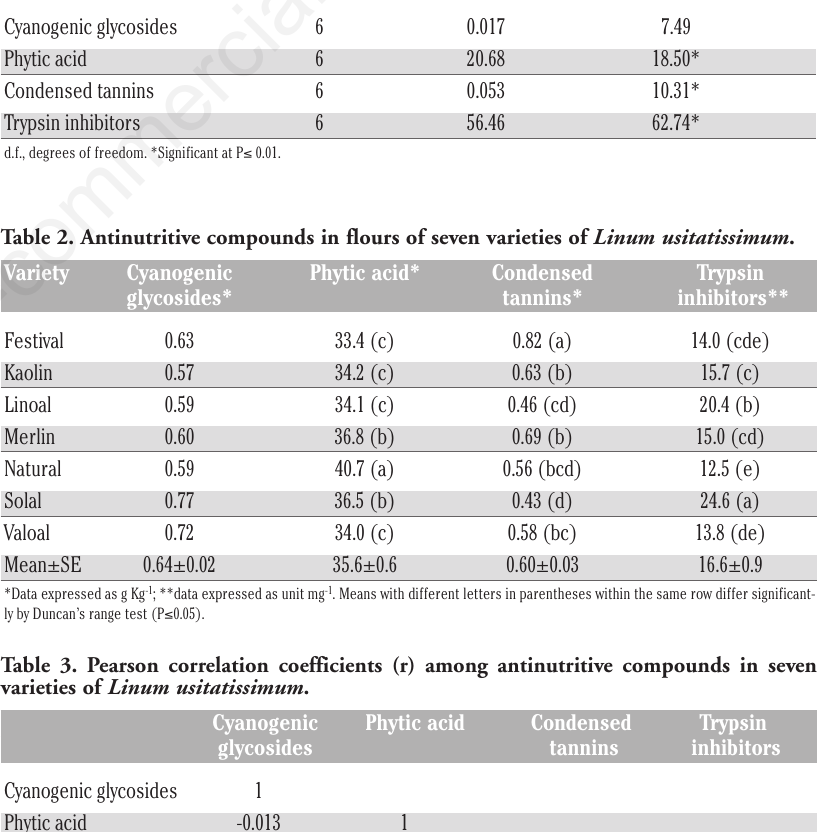
Table 1. Mean square and F value from Analysis of Variance (ANOVA) for antinutritive compounds in flours of seven varieties of Linum usitatissimum . Chemical compound